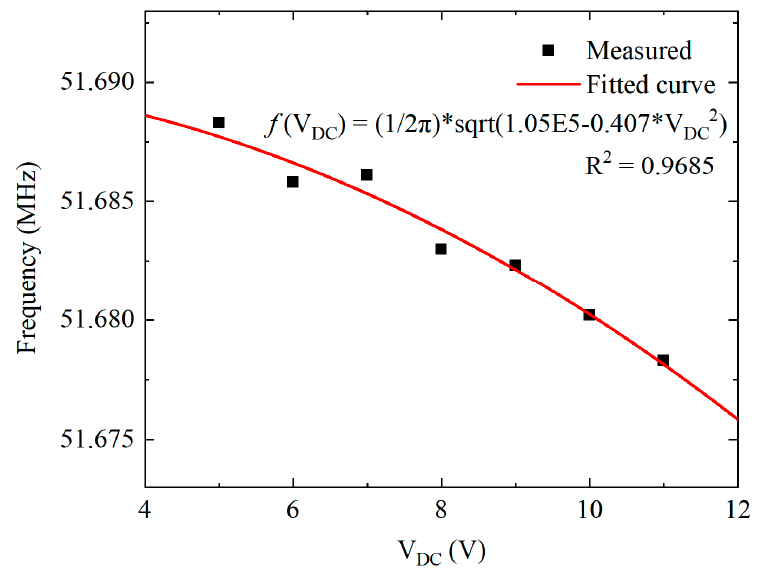
Figure 9. The fitted curve of frequency changes versus the bias voltage of Lamé-mode resonator.